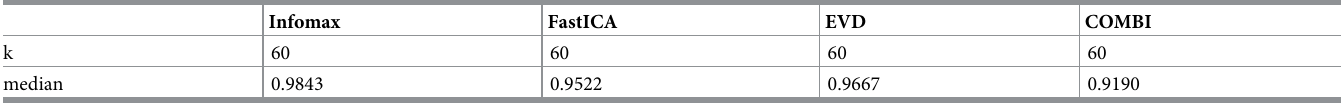
Table 2. ICASSO repetition number k with the highest median Iq of each algorithm (sensory data).